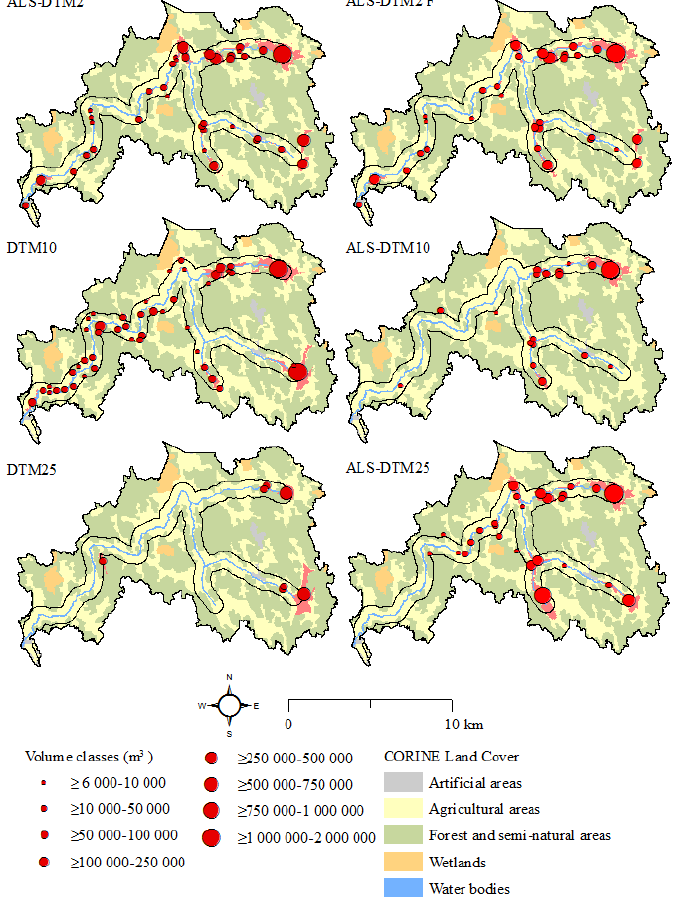
Figure 9. Locations and volume classes of depressions that met the set